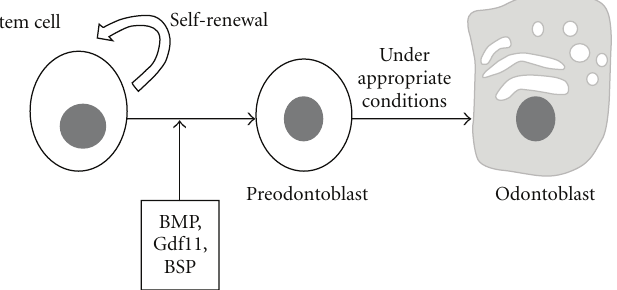
Figure 2: Di ff erentiation of stem cell induced by appropriation signals such BMPs, Gdf11, or BSP into preodontoblast which can di ff erentiate into odontoblast which can finally regenerate